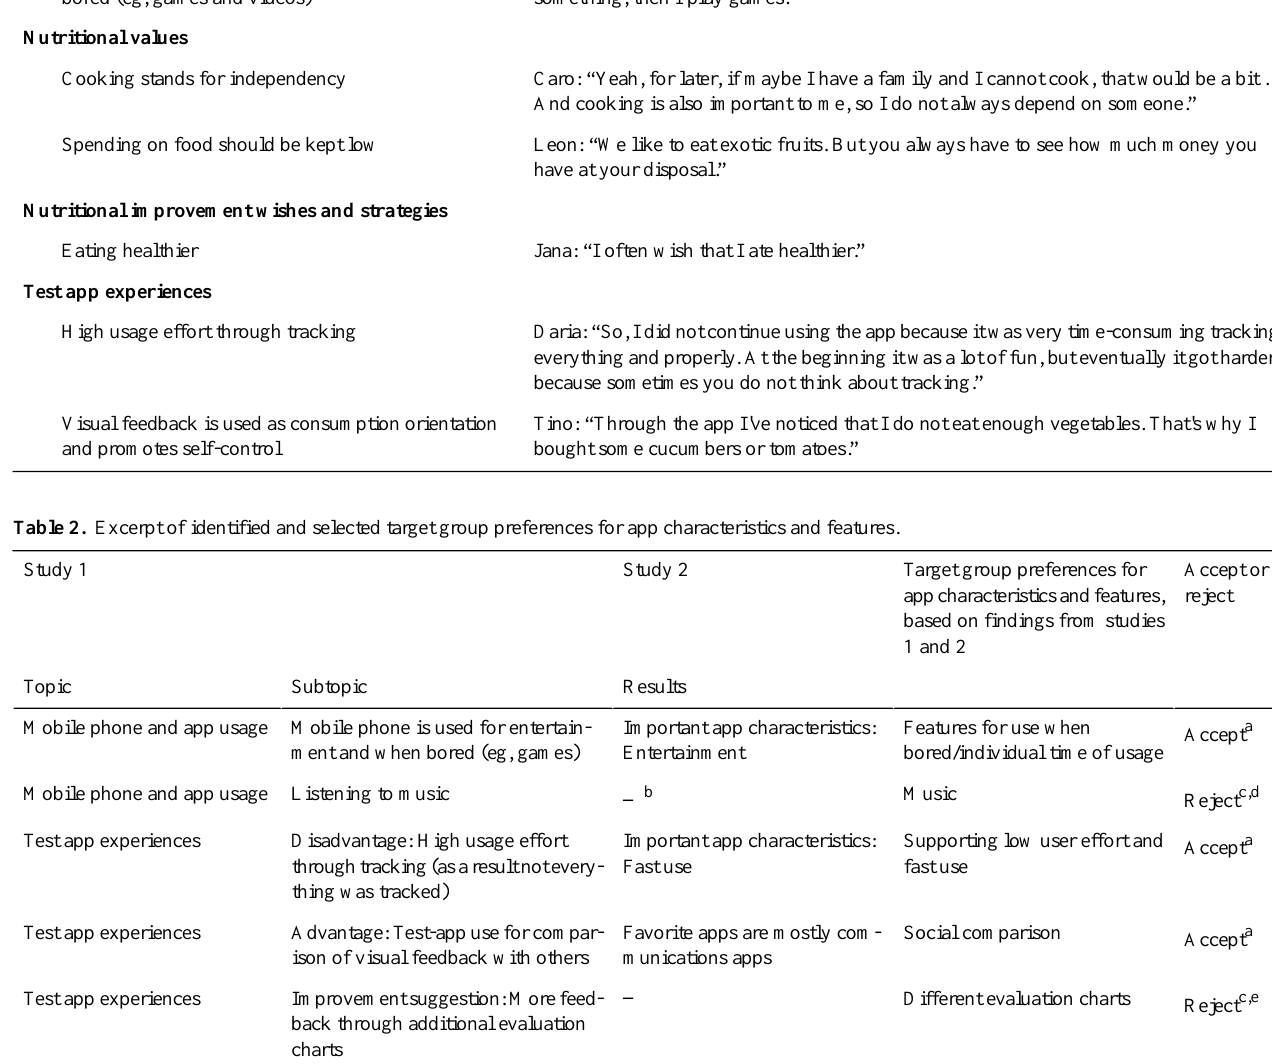
Quotes (translated)Main topic, subtopics